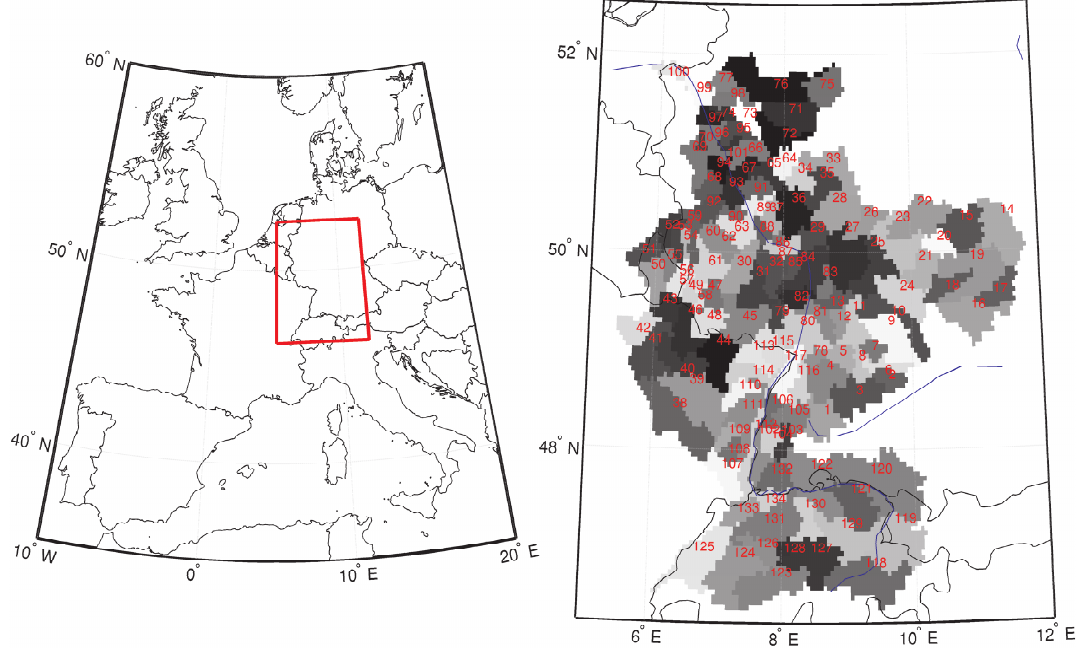
Fig. 1. Left: location of the Rhine basin in Europe. Right: location of the 134 sub-basins for which observations are available at a temporal resolution of 1